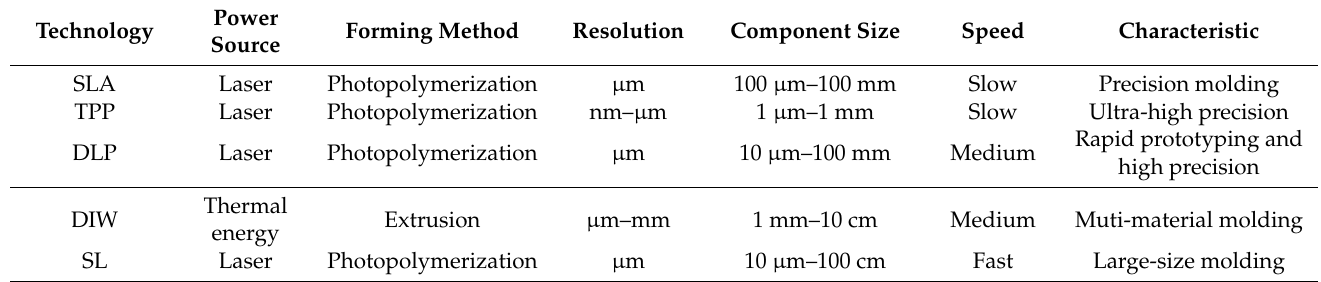
Table 3. Comparison of the different 3D printing technologies used for glass